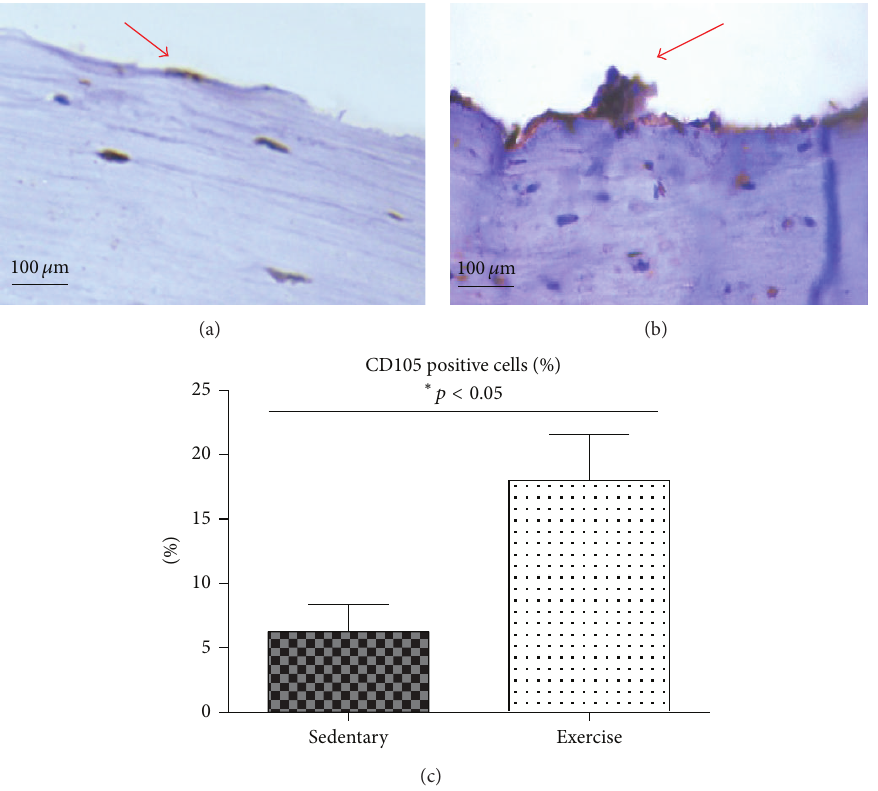
Figure 3: (a, b) Immunohistochemical stainning the CD105 + cells stained immunohistchemically in the sedentary group (a) and exercised (b) group. Positive reactions are indicated by red arrows. Quantification of CD105 positive cells; results representative of six randomly choosen pictures are expressed as mean ± SD ( ∗ 𝑝 value < 0.05).